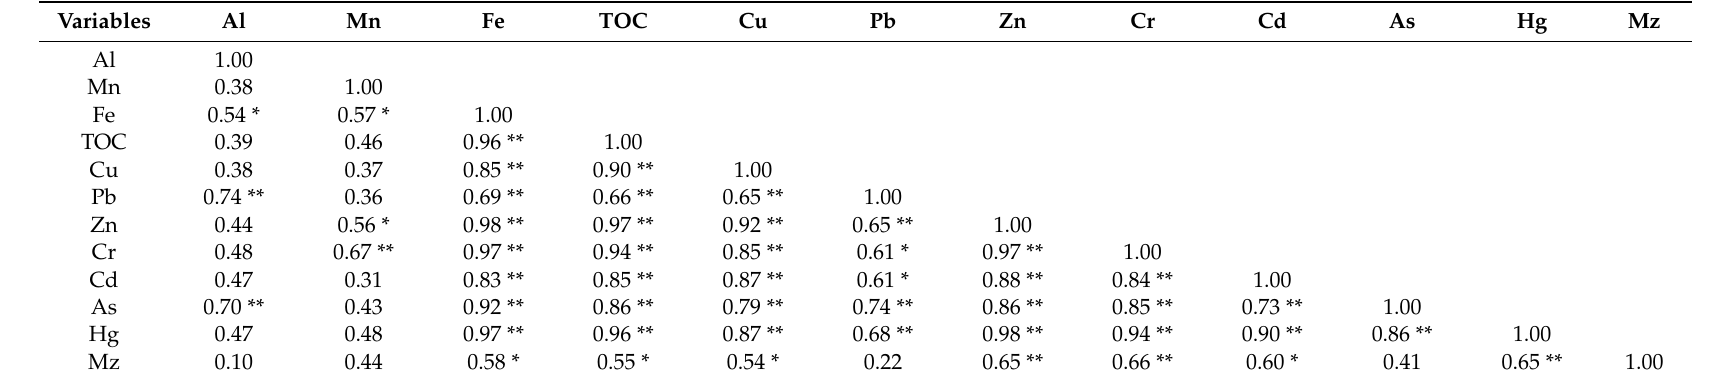
Table 5. Pearson’s correlation matrix for the heavy metals and metalloids and selected elements (Al, Fe, Mn), total organic carbon (TOC) and mean grain size (Mz) (n = 15) in the